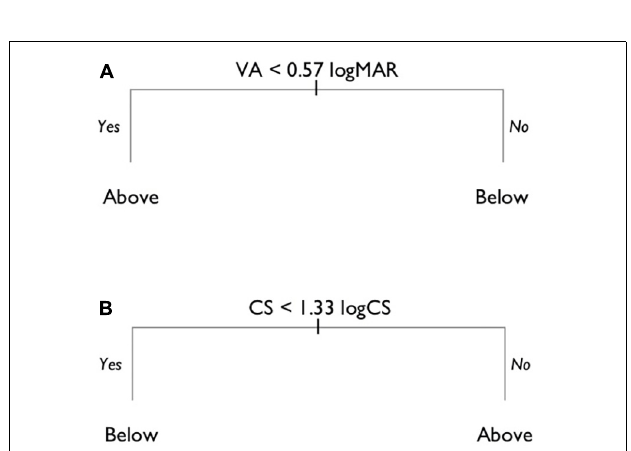
FIGURE 5 | Constrained decision tree model. (A) Decision tree model in which VA was first forced into the model, with a VA of 0.57 logMAR found to be the initial cut-off criterion. (B) The pruned decision tree on the subset of the data after eliminating the observations where VA was 0.57 logMAR or